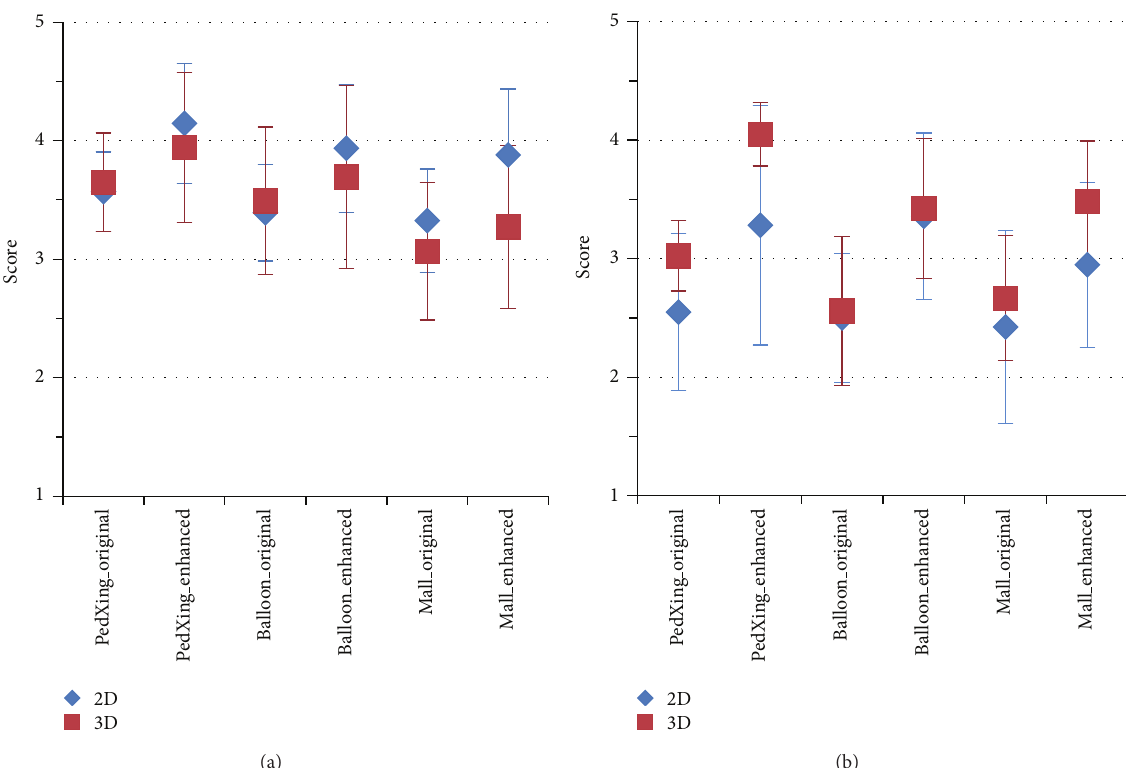
Figure 4: A comparison of the 95% confidence intervals between (a) experiment 1 and (b) experiment 3. Since the number of participants was different in experiments 1 and 3, we corrected for this difference by six times randomly selecting six participants of experiment 1 and using the average of the corresponding 95% confidence